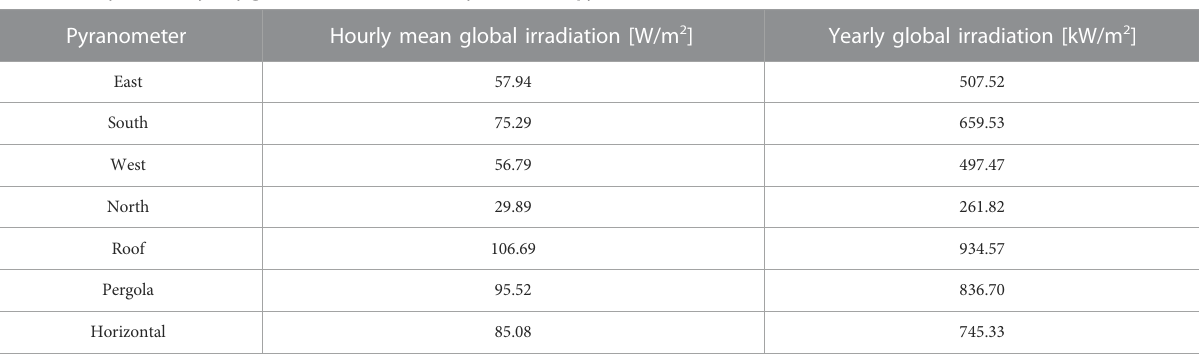
TABLE 5 Hourly mean ad yearly global irradiation over the year for each